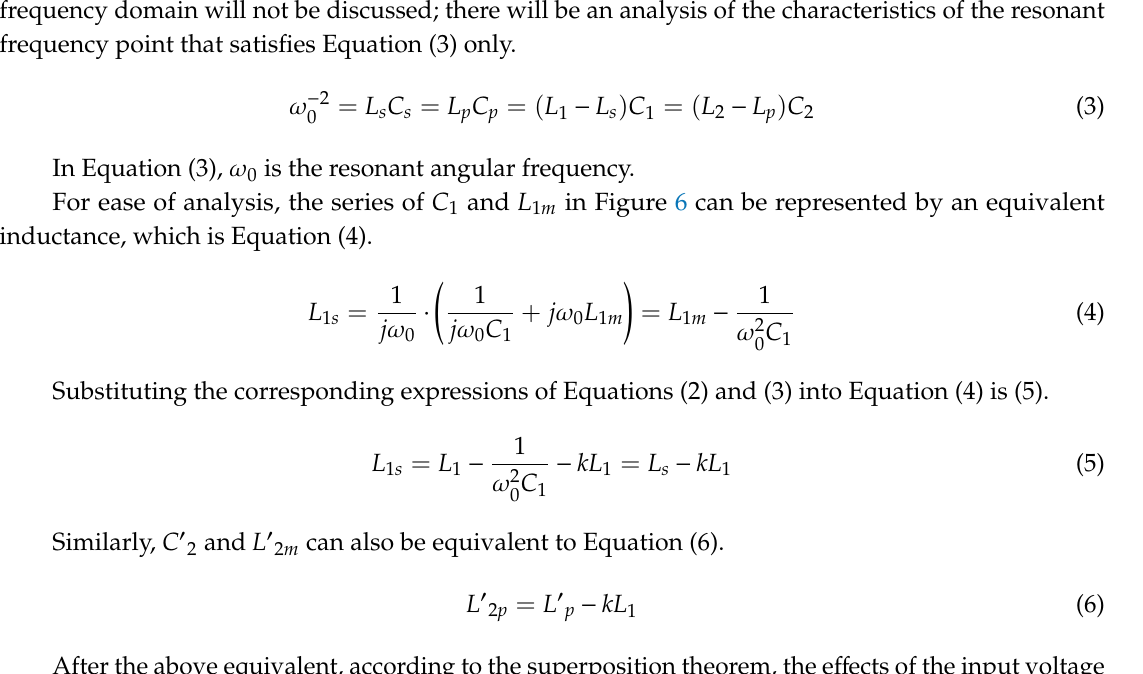
Figure 7. Circuit state of a resonant network acted on by